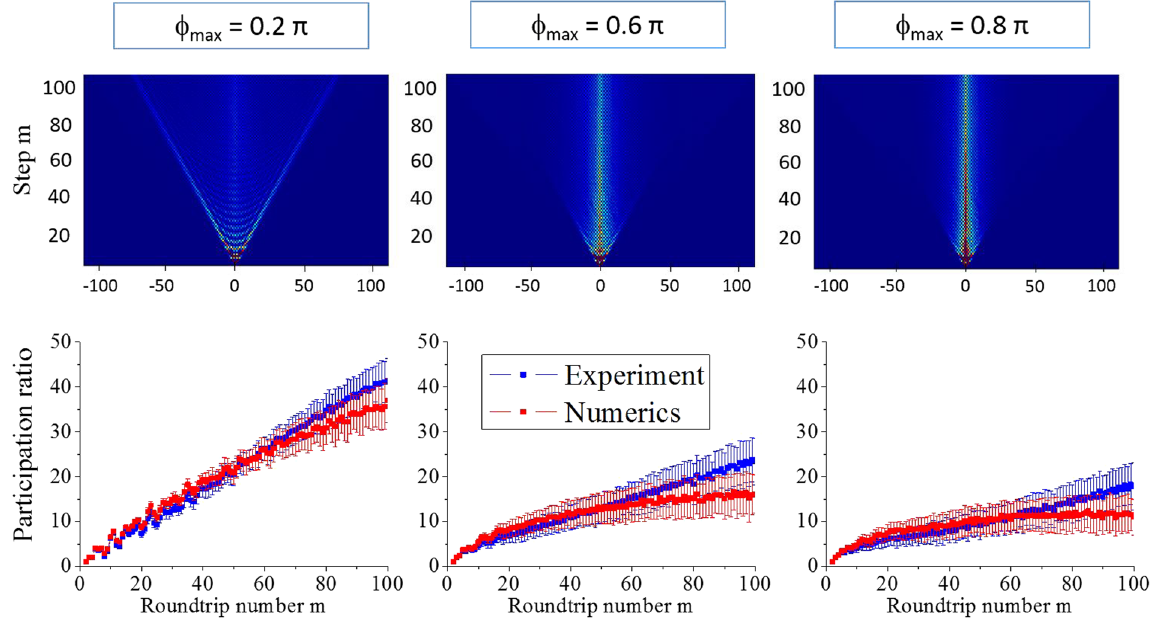
Figure 2. Upper panel: Experimental pulse evolution in synthetic photonic lattices with different strengths of randomly distributed potential as indicated by labels. Lower panel: corresponding evolution of the participation ratio determined from experimental data and numerical simulations. All data is averaged over 100 realizations and the variance of the participation ratio is calculated.